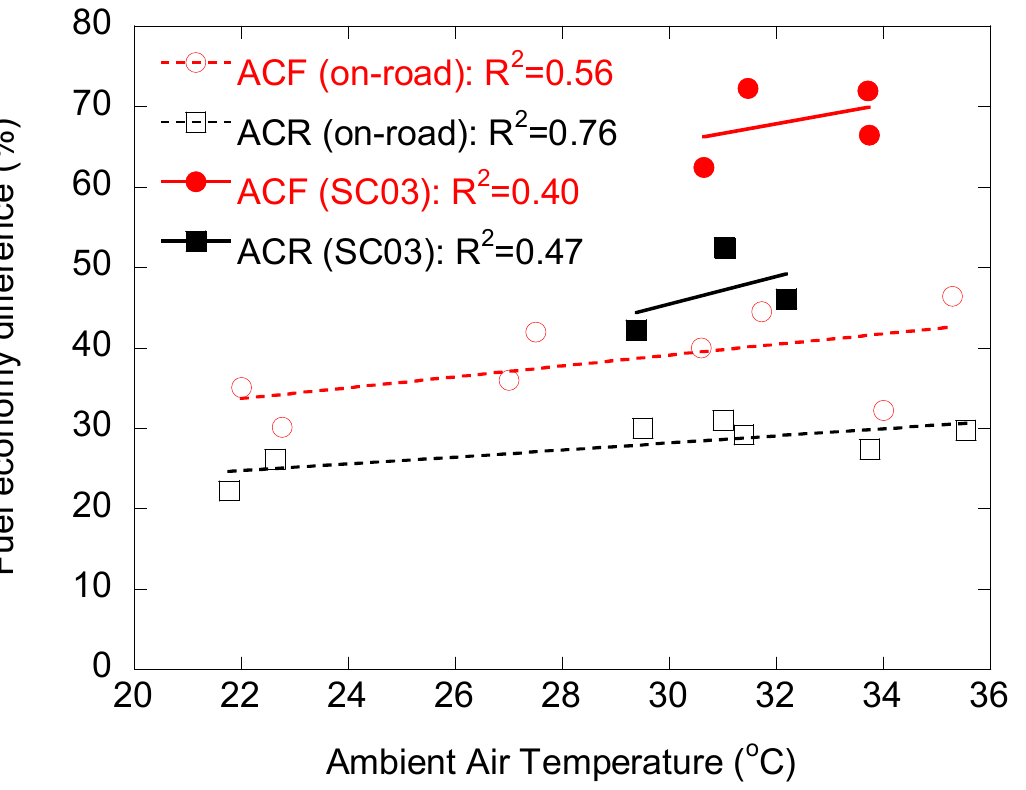
Figure 7. Difference in fuel economy relative to average ACO conditions result.